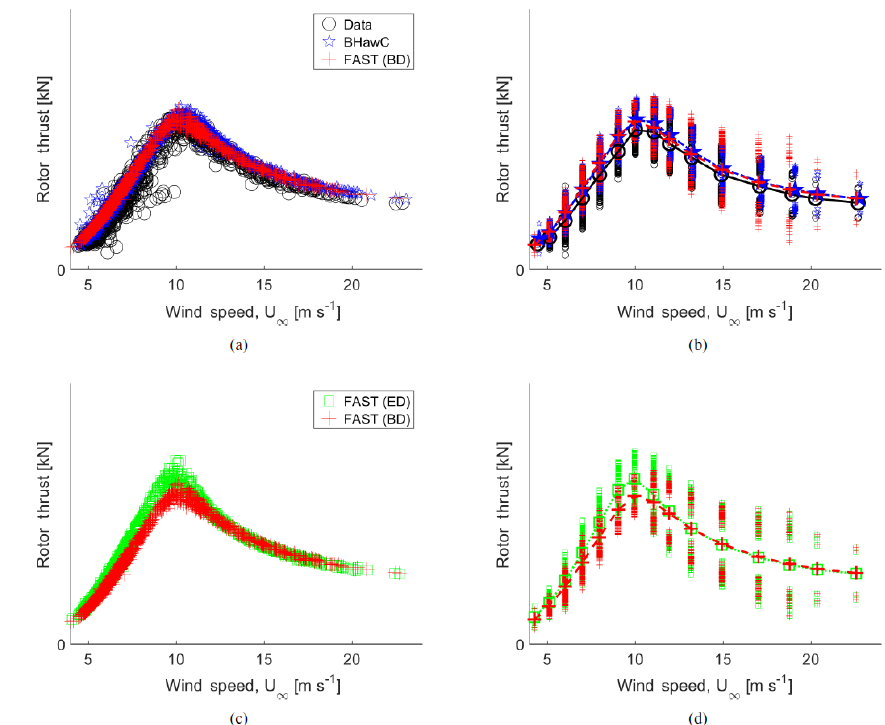
Figure 3. Rotor thrust force. (a) Individual 10min averages from experimental data, BHawC, and FAST (BD). (b) Binned averages of data in (a) are denoted by points connected by lines; the scatter above and below these data denotes plus or minus 1 standard deviation, respectively, of the individual 10min data sets in that bin. (c) Individual 10min averages from FAST (BD) and FAST (ED). (d) Binned averages of data in (c) are denoted by the points connected by lines; the scatter above and below these data denotes plus or minus 1 standard deviation, respectively, of the individual 10min data sets in that